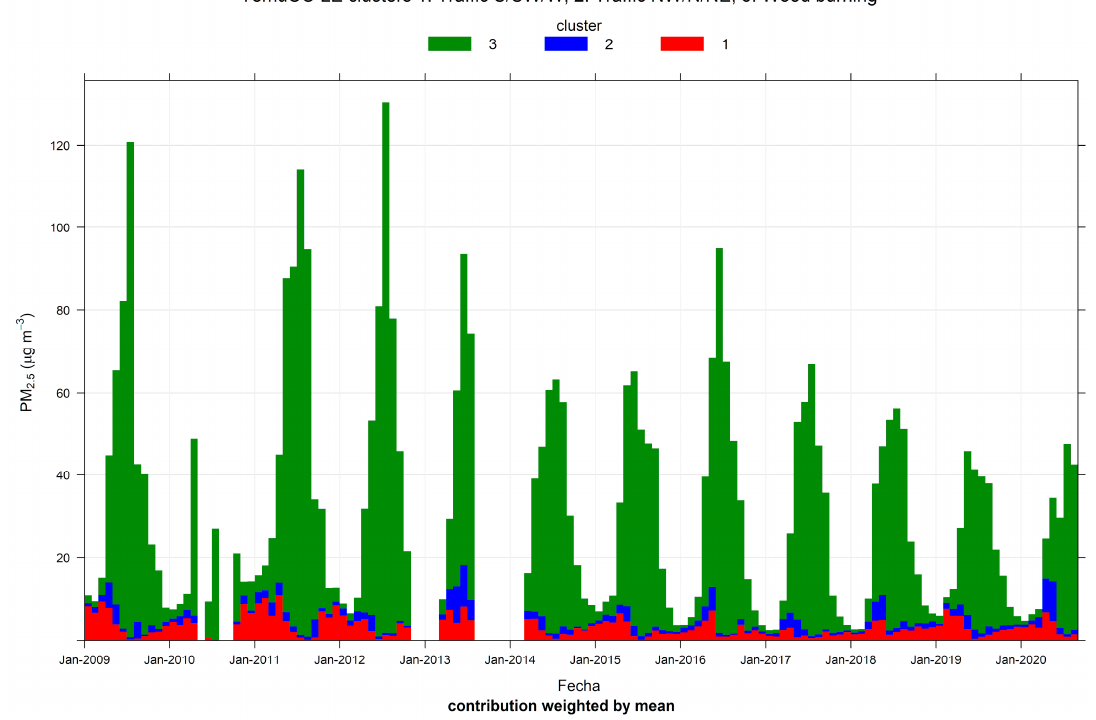
Figure 8. Cluster analysis source apportionment results for ambient PM 2.5 at Temuco, 2009/01–2020/08, for a three-cluster solution.